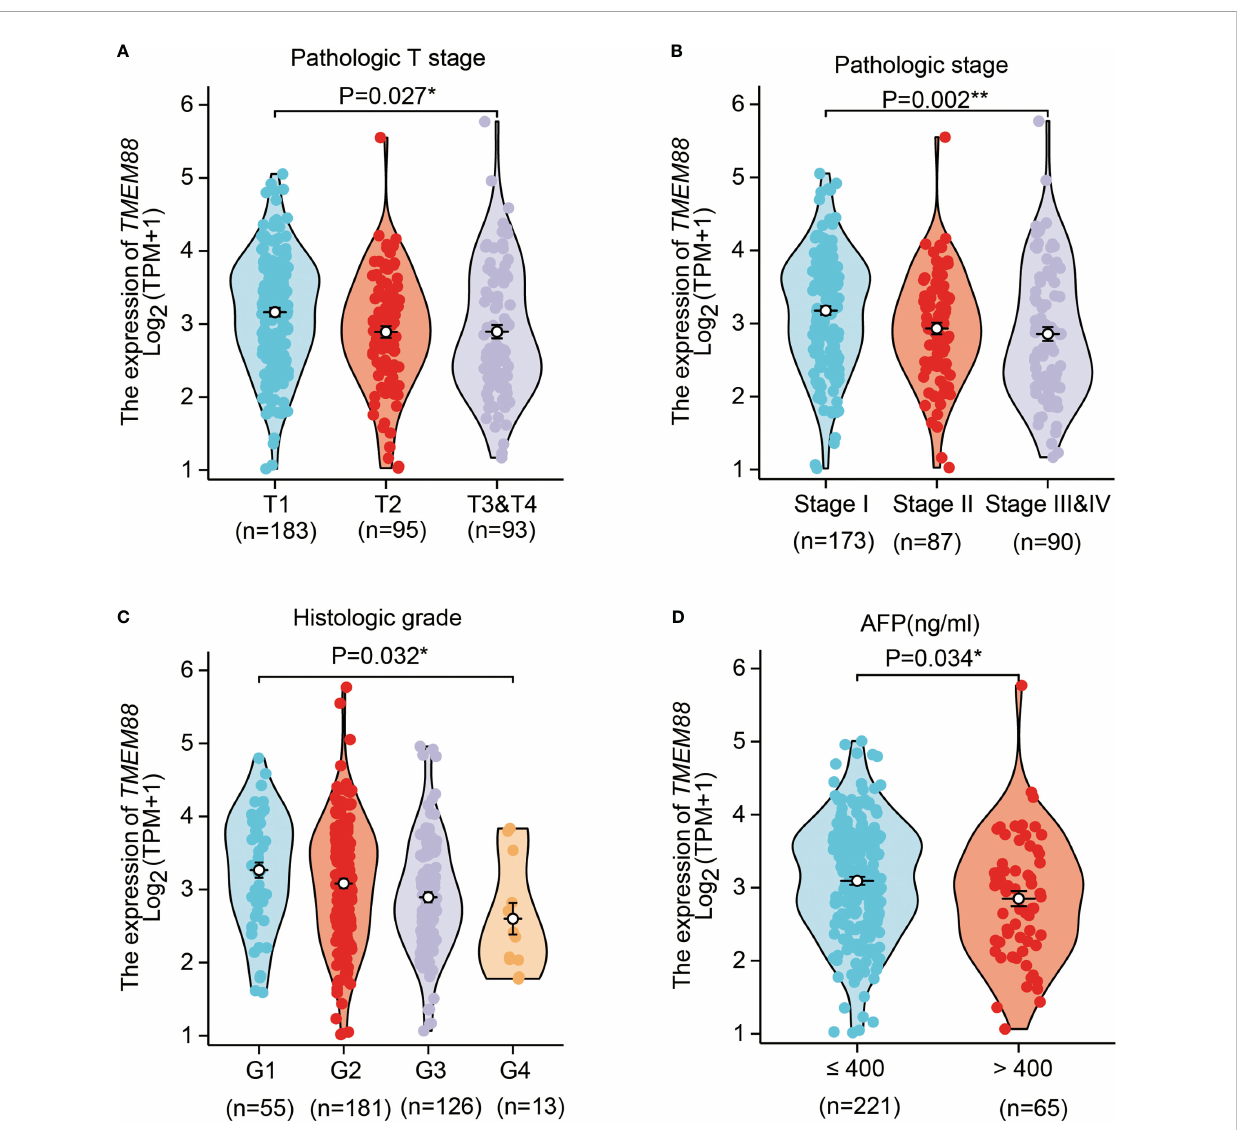
FIGURE 2 TMEM88 mRNA level was correlated with certain HCC characteristics. The correlations between TMEM88 mRNA levels with HCC T stage (A) , TNM stage (B) , histological grade (C) , and patients serum AFP level (D) were analyzed, respectively. Data was analyzed by Student ’ s t-test between each two groups. *P<0.05,